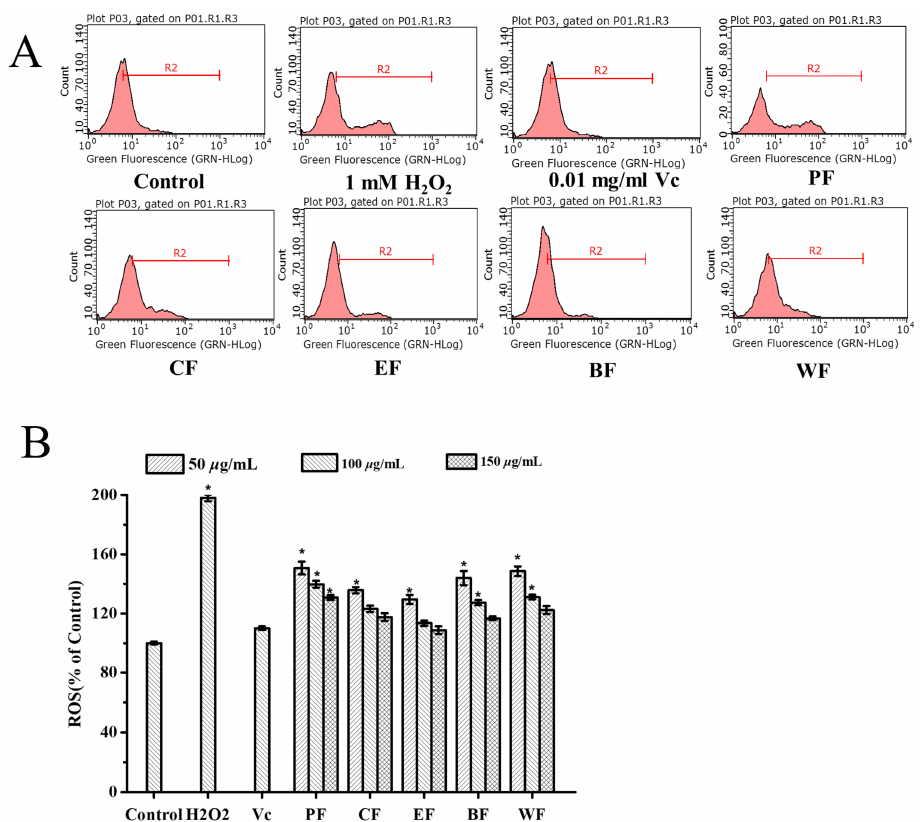
Figure 3. The inhibitory effects of cellular ROS generation under treatments of PF, CF, EF, BF, and WF from V. dunalianum in H 2 O 2 -induced HepG2 cells. ( A ) The inhibition of cellular ROS production by five fractions at the concentrations of 100 µ g/mL. ( B ) The inhibition of cellular ROS production by five fractions at the concentrations of 50, 100, and 150 µ g/mL. Means (bar values) with different letters are significantly different ( p < 0.05). PF, CF, EF, BF, and WF denoted petroleum ether fraction, chloroform fraction, ethyl acetate fraction, n -butanol fraction, and water